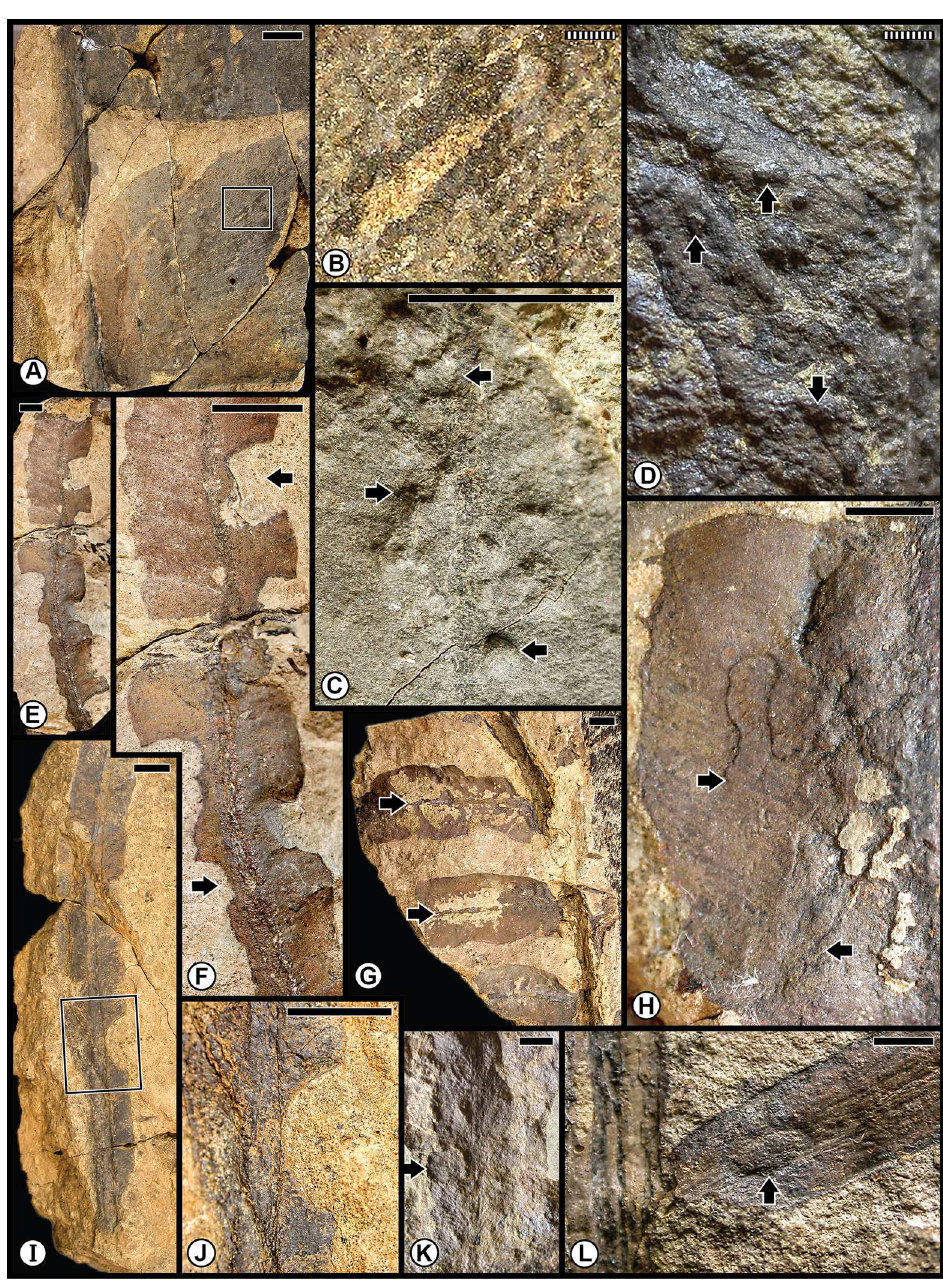
Fig 9. Plant–insect interactions from the Middle Triassic (Ladinian) Monte Agnello Flora, of the Vulcanites near Predazzo in the central Dolomites. A : Foliage of the sphenophyte cf. Schizoneura paradoxa with slot feeding (DT08). Specimen MGP-194-106. B : Enlargement of slot feeding (DT08) indicatedin the rectangular template in (A). C : The fern Phlebopteris fiemmensis , exhibitingDT80 galls. Specimen MGP-181-57C. D : Another specimen of Phlebopteris fiemmensis , showingsmall, foliar galls (DT80). Specimen MGP-181-57C. E : The pteridosperm Scytophyllum bergeri displayingcuspate margin feeding(DT12) along blade edges and margin feeding of the terminus (DT14). Specimen MGP-63-97. F : Enlargedmagnification of DT12 shown at the left polygontemplate in (E), illustrating veinal stringers and cuspate excisions (black arrows). G : Three pinnulesof Scytophyllum bergeri showingsurface feeding (DT82), the two more prominent examplesof which are indicatedby white arrows. Specimen MGP-196-39A. H : A pinnulularblade of Scytophyllum bergeri , showinga thin leaf mine (DT41), with the upper-left arrow showingthe mine origin and the lower-rightarrow showingthe mine probably aborted end. Specimen MGP- 63-98A. I : An additionalspecimen of Scytophyllum bergeri , displayingexamplesof margin feeding